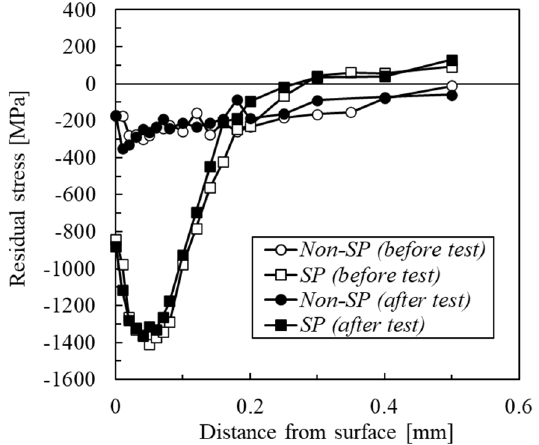
Figure 6. Distribution of residual stress.